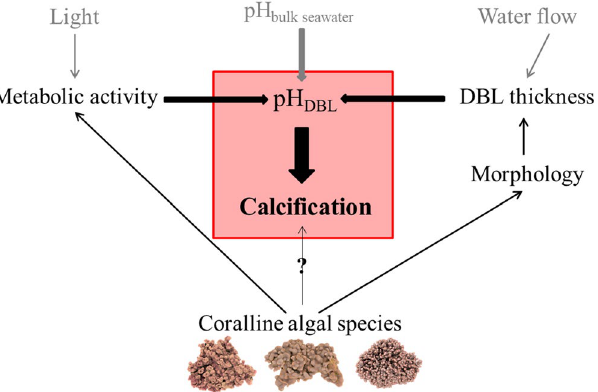
Figure 7. Schematic overview of the relationship between the pH within the DBL (pH DBL ) and coralline species’ calcification rates, as well as the biotic (black) and abiotic factors (grey) affecting directly (thick arrows) and indirectly (thin arrows) the pH DBL and hence, calcification. The influence of species-specific differences in the calcification mechanism cannot be excluded, but further information is required to infer about the effect on species’ calcification